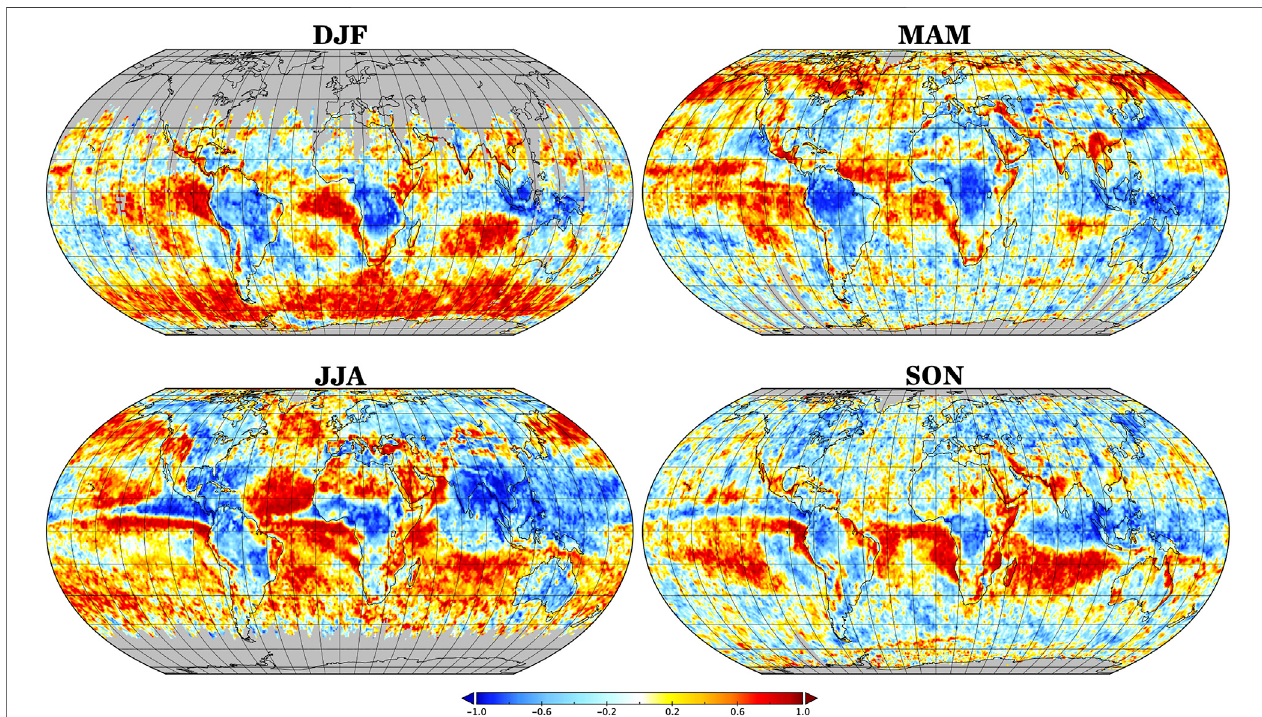
Frontiers in Remote Sensing |